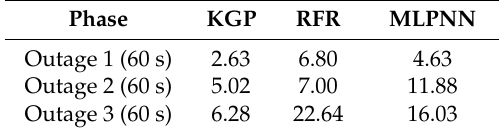
Table 5. Comparison results of RMSE with different